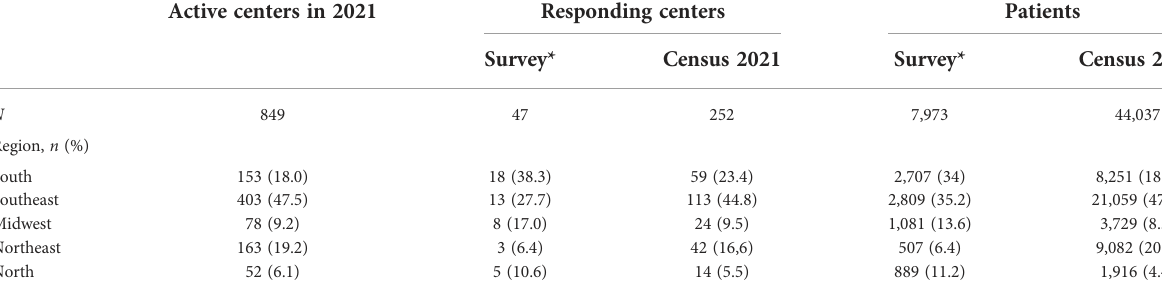
TABLE 4 Number of active dialysis clinics and patients of the of fi cial Census and the study survey.